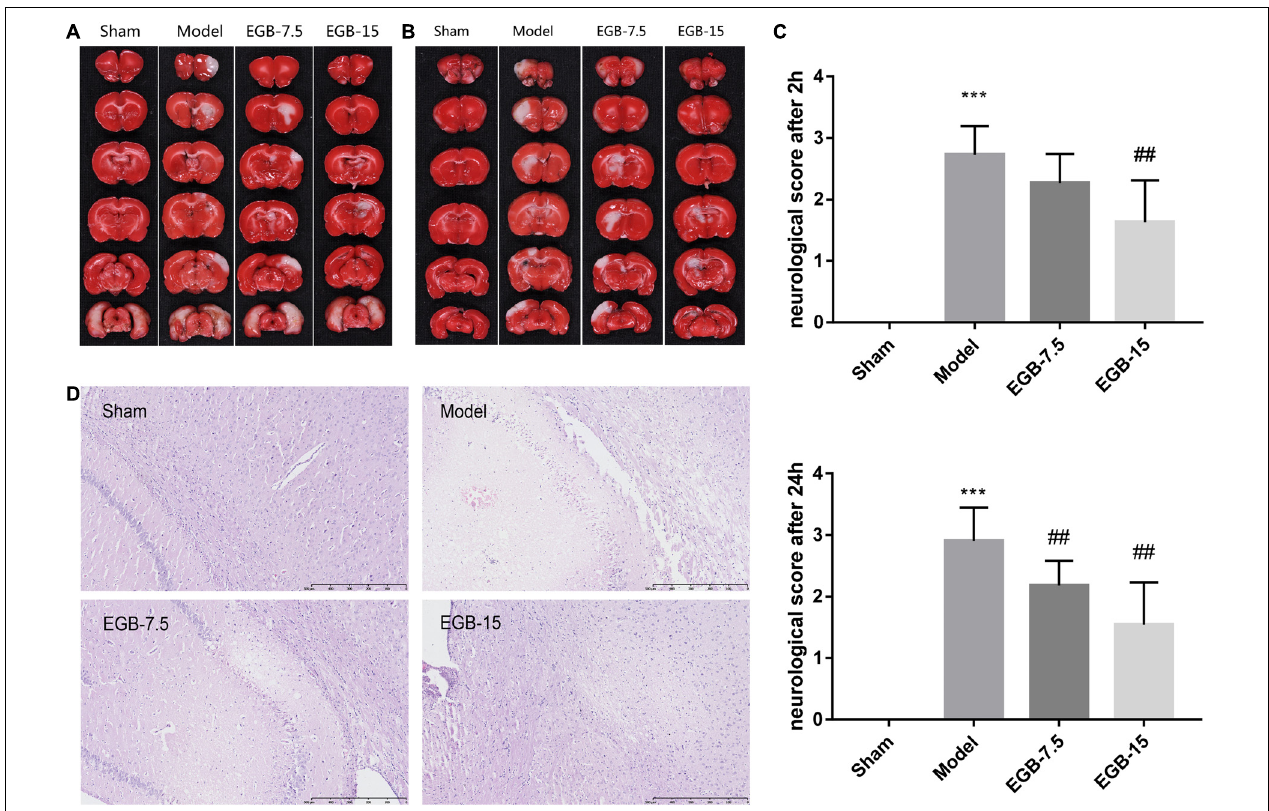
FIGURE 1 | EGB treatment reduced ischemic infarct volume in the cerebral ischemia model. (A,B) Cerebral infarct volume was assessed via TTC staining 48 h after cerebral ischemia. Neurological score (C) of rats after cerebral ischemia were assessed using a five-point scale system. Data are expressed as mean ± SEM ( n = 10). ∗∗∗ p < 0.01 vs. sham group; ## p < 0.01 vs. the model groups. The ischemic penumbra area in the box (D) was assessed for neuronal apoptosis using HE